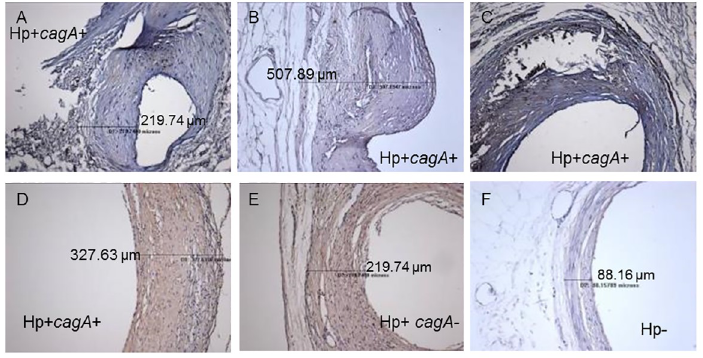
Fig 9. Coronary artery pathology seen in H . pylori- infected and uninfected macaques. Panels A, B, C, and D show arteries from cagA positive ( cagA+ ) animals. Panels A and C show severe necrosis. Panel B shows an atypical bulging plaque. Panels D, E, and F depict arteries that are near the median intimal thickness values for cagA- positive, cagA- negative ( cagA- ), and uninfected (Hp-) animals, respectively. Measurement lines shown in some images indicate the maximal intimal thickness for those